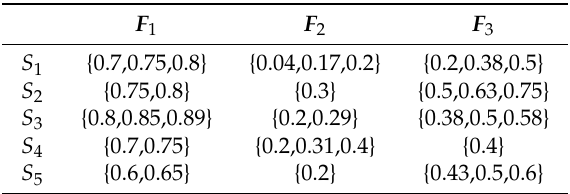
Table 2. Hesitant fuzzy decision matrix.